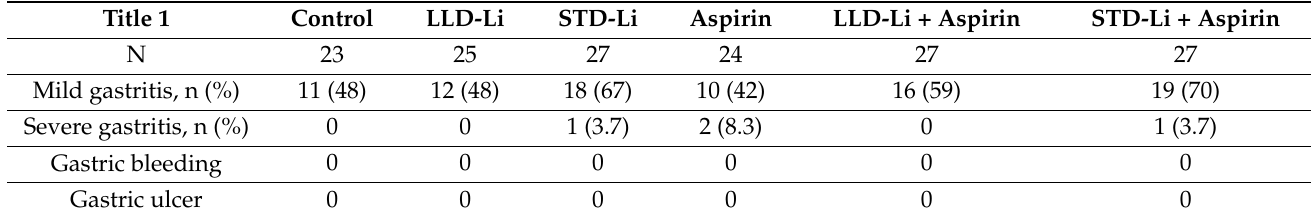
Table 1. Gastric mucosal integrity in aspirin + Li-treated rats.